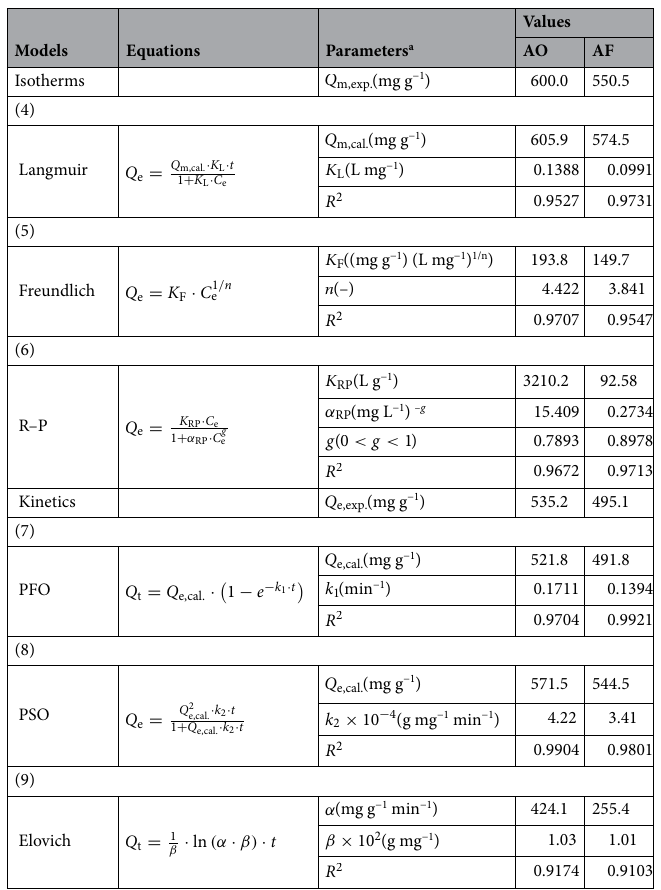
Table 2. Nonlinear forms of isotherms and kinetics equations and corresponding parameters and values. a Q m,exp. : experimental maximum adsorption capacity; Q m,cal. : calculated maximum adsorption capacity; K L : Langmuir isotherm constant; K F : Freundlich isotherm constant; n : Freundlich isotherm constant; K RP and α RP are R-P isotherm constant; g is R-P isotherm constant; Q e,exp. : experimental adsorption capacity at equilibrium; Q e,cal. : calculated adsorption capacity; k 1 : PFO rate constant; k 2 : PSO rate constant; α and β are Elovich kinetic